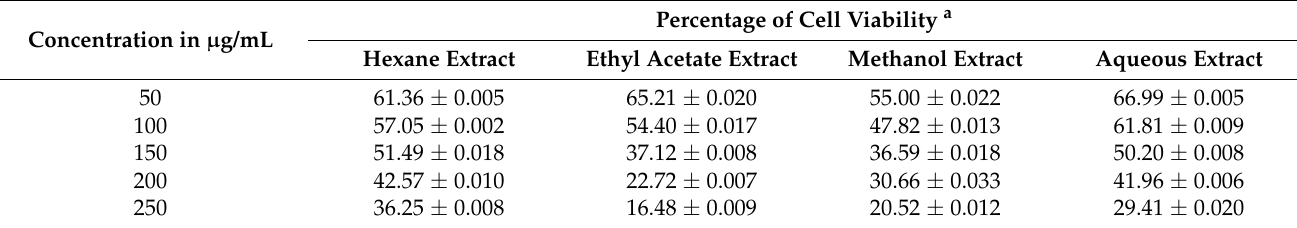
Table 3. Anticancer activity of different solvent extracts of C. colocynthis against the breast cancer MCF-7 cell line.